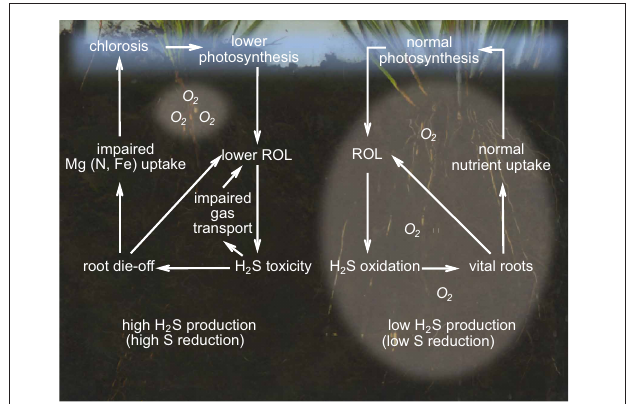
FIGURE 5 | Conceptual model showing positive feedback loops on plant-rhizophere processes under scenarios of sulfide toxicity (left) and non-toxicity (right). See text for further explanation. Unlike in other studies, impaired uptake of N or Fe was not found in this study. Impaired gas transport by sulfide has been shown by Armstrong et al. (1996). Sulfide oxidation is carried out by free-living prokaryotes in sediment and water, symbiotic prokaryotes of roots and soil fauna, and mitochondrial metabolism in soil fauna and